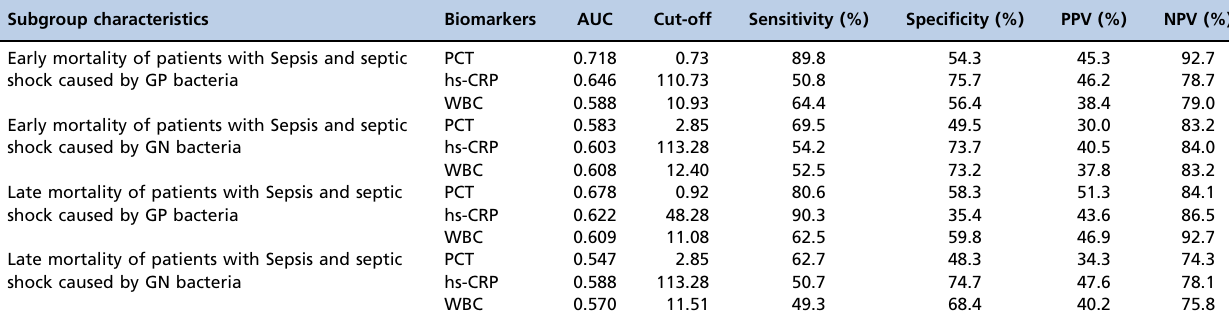
Table 4 - Diagnostic values of laboratory findings in predicting early and late mortality of patients with sepsis and septic shock caused by GPB or GNB. Subgroup